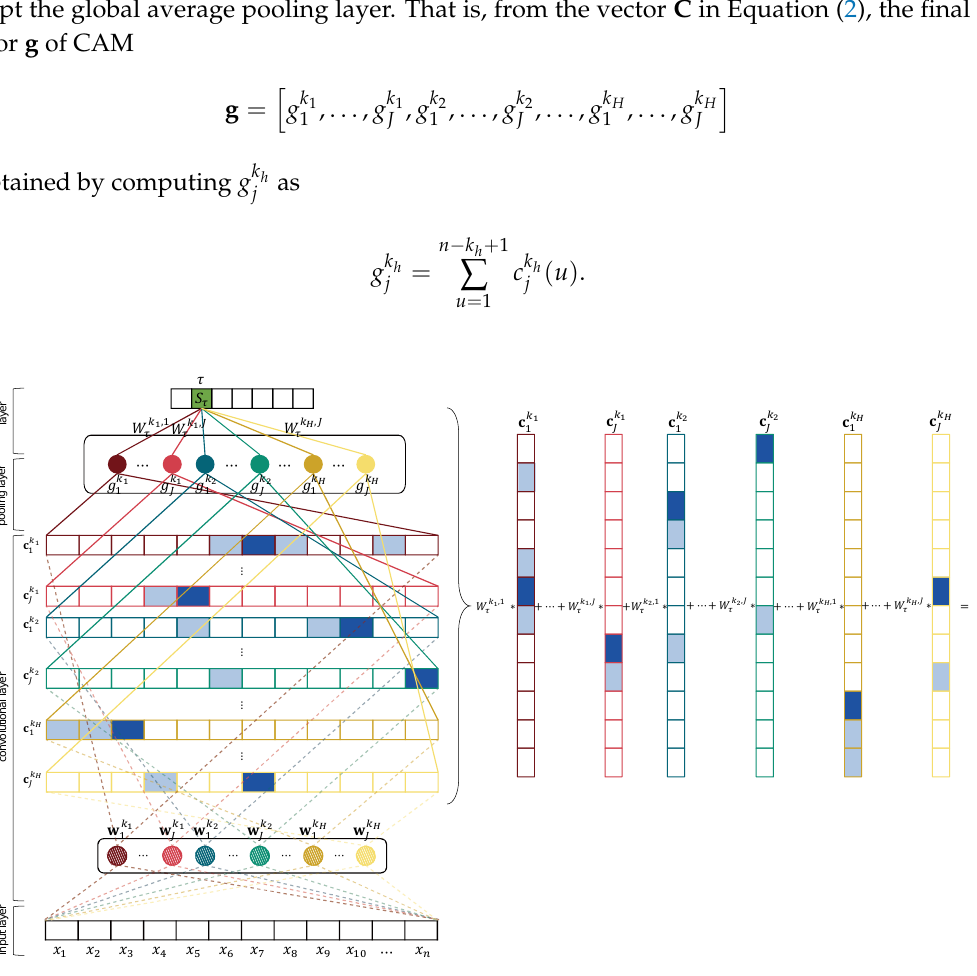
Figure 1. The architecture of class activation map (CAM) applied to text